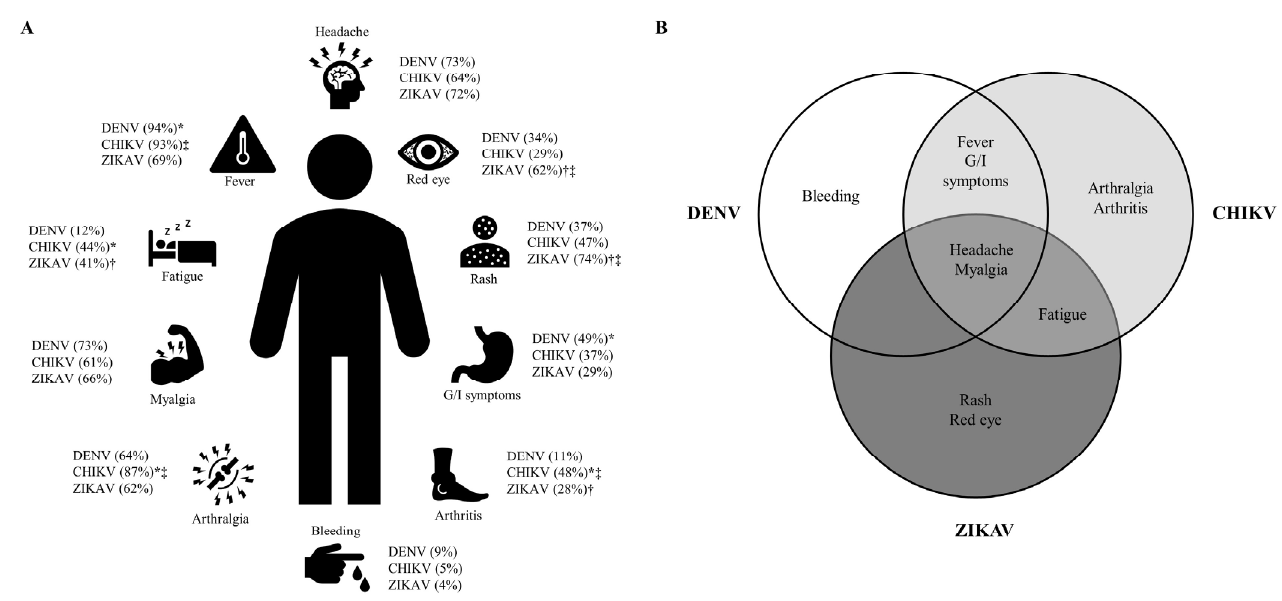
Figure 2. Common symptoms in arboviral infection (DENV, CHIKV and ZIKAV). Shown are the common symptoms in DENV, CHIKV and ZIKAV. In panel ( A ) are the percentages and statistical significance ( p < 0.05) of each symptom between DENV-CHIKV (*), DENV-ZIKAV (†) and CHIKV- ZIKAV (‡). In panel ( B ) are depicted the shared and single statistically significant symptoms between CHIKV, DENV and ZIKAV. See supplementary Tables S1 and S2 for references. DENV: Dengue virus; CHIKV: Chikungunya virus; ZIKAV: Zika virus.